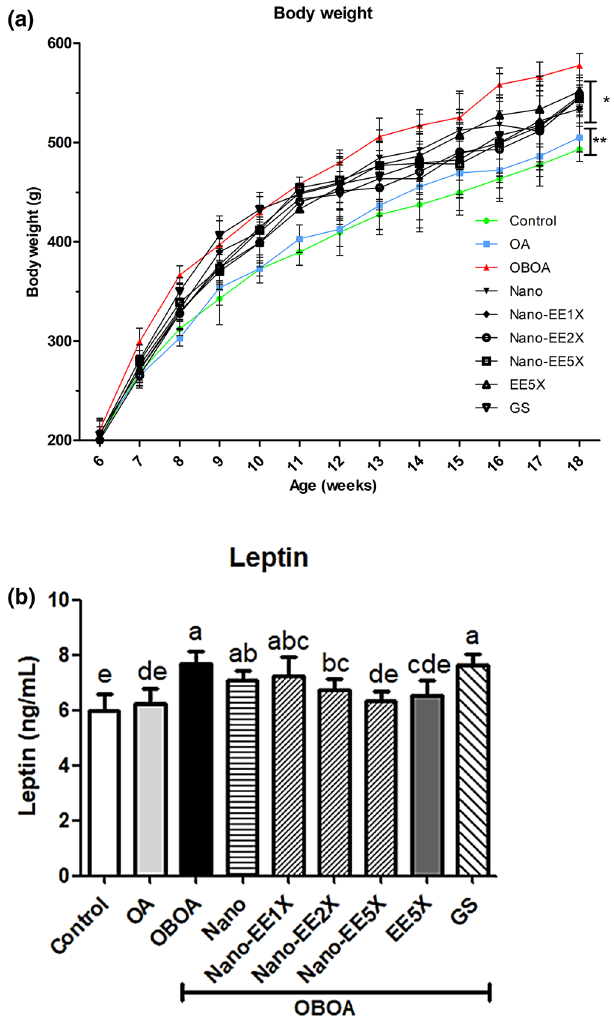
Figure 3. ( a ) Body weight of rats during the experiment and ( b ) Plasma leptin level in osteoarthritis rats fed different doses of Nano-EE and EE after 6 weeks. Data are shown as the mean ± SD (n = 6 rats/group). The level of leptin was analyzed by the ELISA kit. Control: sham group; OA: osteoarthritis; OBOA: obesity and osteoarthritis; Nano: obesity and osteoarthritis + 298 mg/kg per day chitosan and silica mixture; Nano-EE1X: obesity and osteoarthritis + 93 mg/kg per day Nano-EE; Nano-EE2X: obesity and osteoarthritis + 186 mg/kg per day Nano-EE; Nano-EE5X: obesity and osteoarthritis + 465 mg/kg per day Nano-EE; EE5X: obesity and osteoarthritis + 167 mg/kg per day EE; GS: obesity and osteoarthritis + 100 mg/kg per day glucosamine sulfate. P < 0.05 (*), P < 0.01 (**) vs.